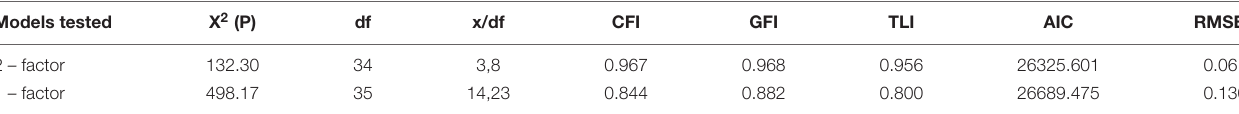
FIGURE 3 | Structural model of the objectification scale after confirmatory analysis. TABLE 4 | Fit indices for the confirmatory factor models of the POWS questionnaire (N =